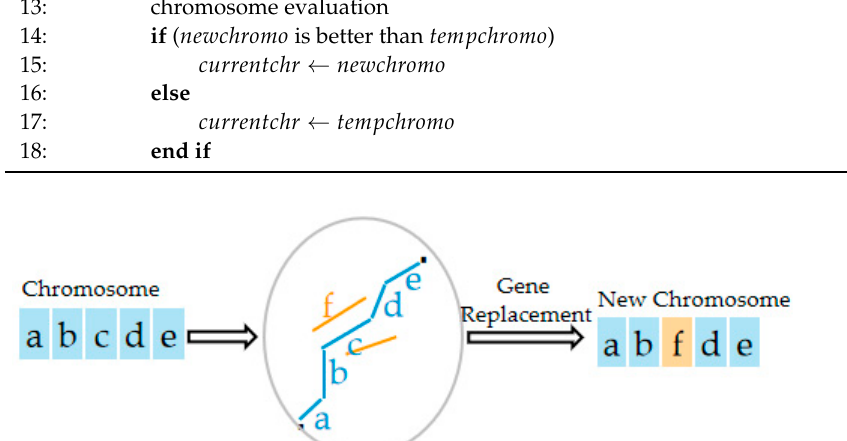
Table 1. Introduction to road network